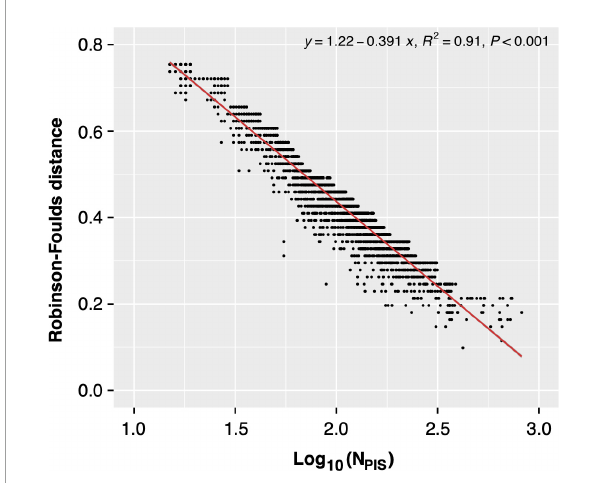
FIGURE6 Regression analysis between Robinson-Foulds (RF) distance [between the single-gene tree and supermatrix (ST1)] and the number of parsimony-informative sites.